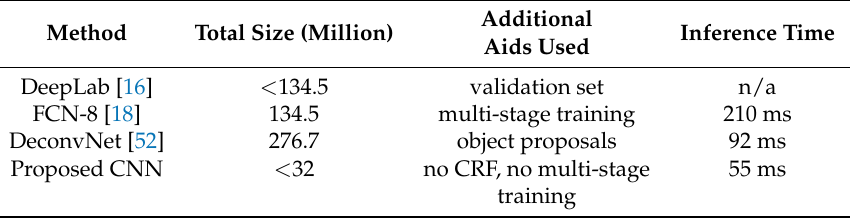
Table 4. ECRU size and inference time